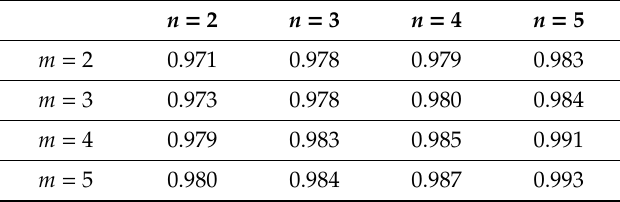
Table 2. Adjusted coe ffi cients of determination (Adj. R 2 ) values for di ff erent polynomials fitting E[Br − ] values, with the degree of x = Meas.[NO 3 − ] ( m ) and of y = Meas.[Br − ] ( n ) listed in the first column and the first row, respectively.